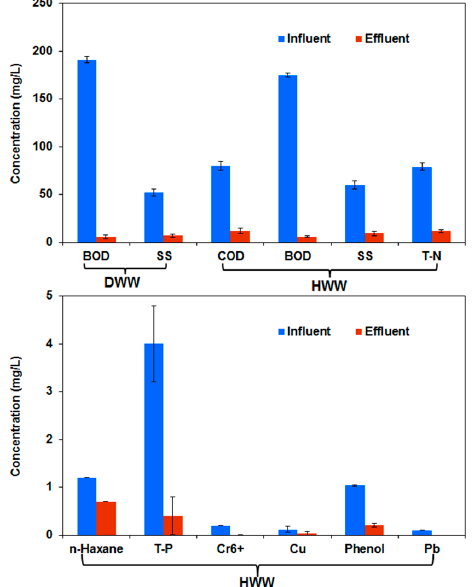
Figure 2. Influent and effluent characteristics of wastewater treatment. Data for one year were averaged with standard deviations. (DWW: domestic wastewater, HWW: hospital wastewater).